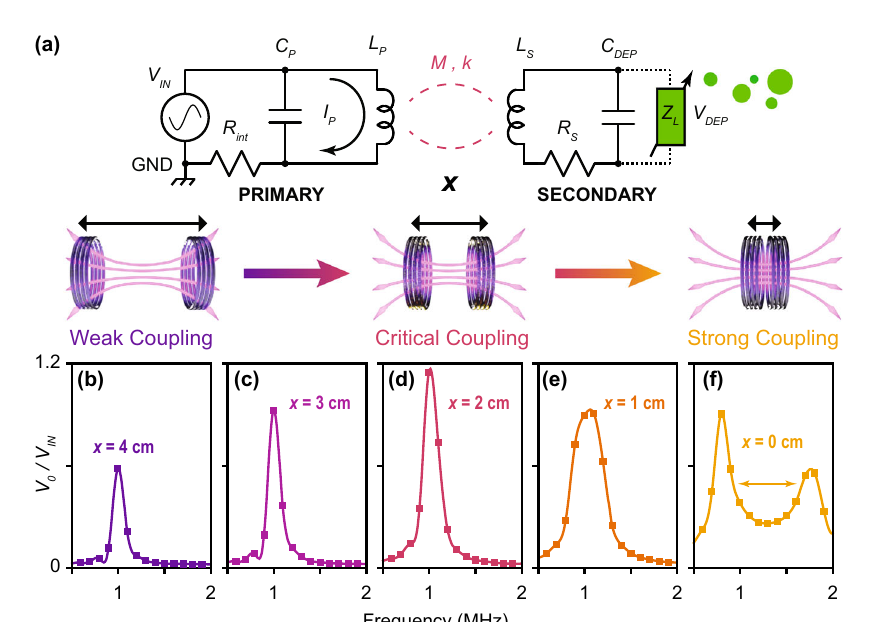
Fig. 2 | Coplanar nanogap fabrication. Cross-sectional, fabrication steps for the coplanarelectrodeDEPdevice. a Step1:Auispatternedtode fi nethe fi rstelectrode. b Step 2: A conformal 20nm Al 2 O 3 layer is deposited using ALD to de fi ne the electrode gap along the edge of the fi rst electrode. c Step 3: Au is evaporated to de fi ne the second electrode. d Step 4: Excess top Au is removed using adhesive